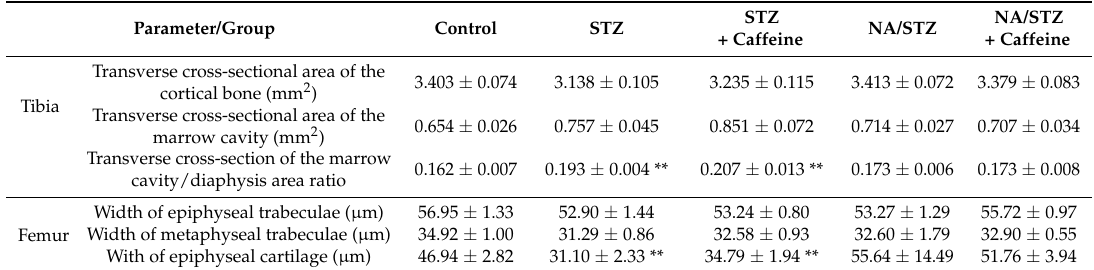
Effect of caffeine administered orally (20 mg/kg daily for four weeks) on bone histomorphometric parameters in rats treated with streptozotocin (STZ) or nicotinamide and streptozotocin (NA/STZ).